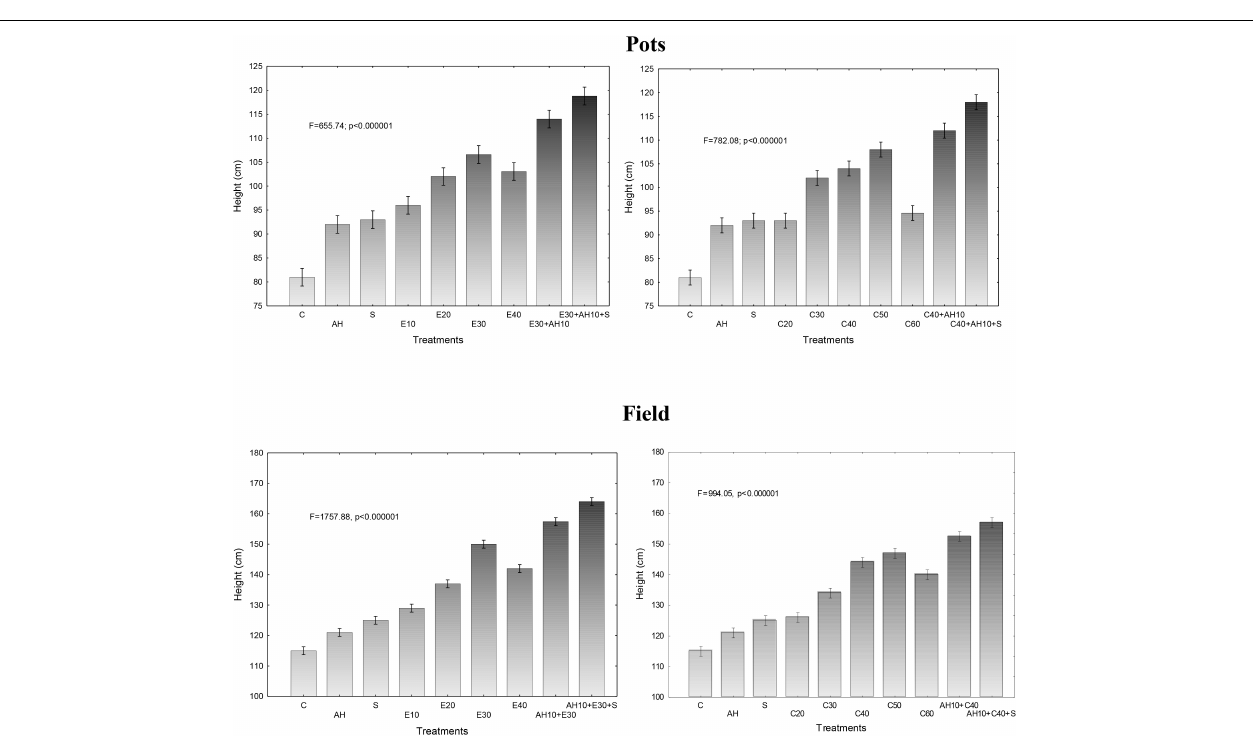
Frontiers in Plant Science |